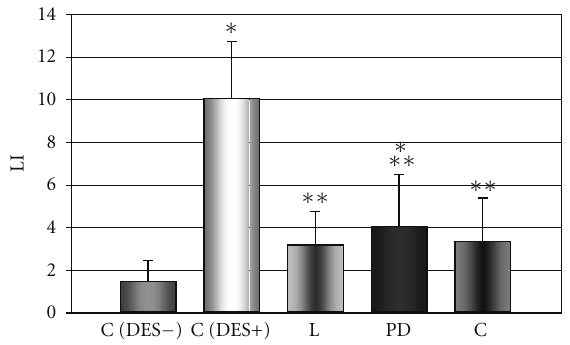
Figure 1: The influence of AT1 receptor antagonist losartan (L), AT2 receptor antagonist PD123319 (PD), and ACE inhibitor captopril (C) on diethylstilboestrol- (DES-) induced increase in number of PCNA immunopositive cells in anterior pituitary of rats. X ± SEM; ∗ P < 0 . 05 versus C (DES − , control DES-untreated group), ∗∗ P < 0 . 05 versus C (DES+, control DES-treated group), LI: labeling index (the number of PCNA-immunopositive cells per 1000 randomly scattered cells of anterior